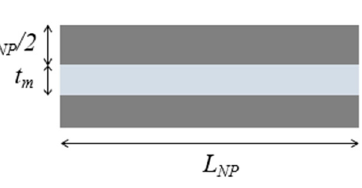
Figure 7. Representative volume element (RVE) of composites reinforced with lamellar nanofiller at high filler content.